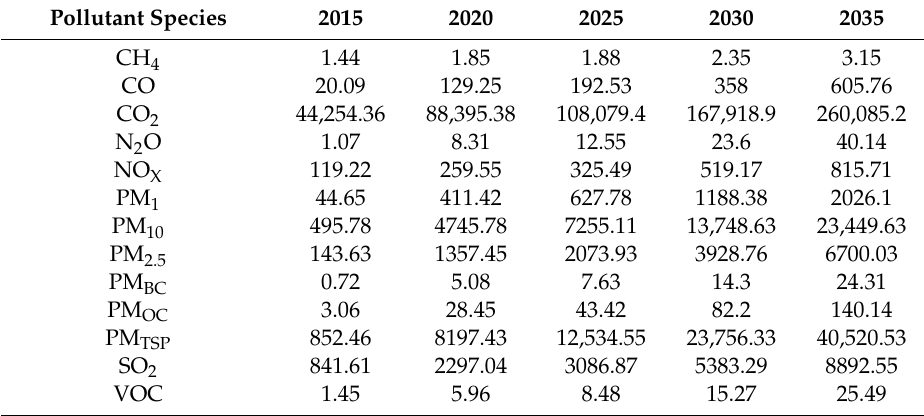
Table 3. Air pollutants emissions in Coal-30 scenario